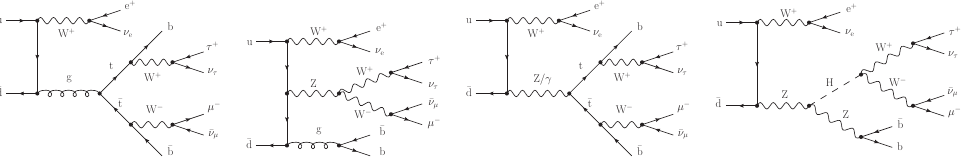
Figure 2: Sample diagrams contributing to LO sections for off-shell ttW + production in the three-charged-lepton decay